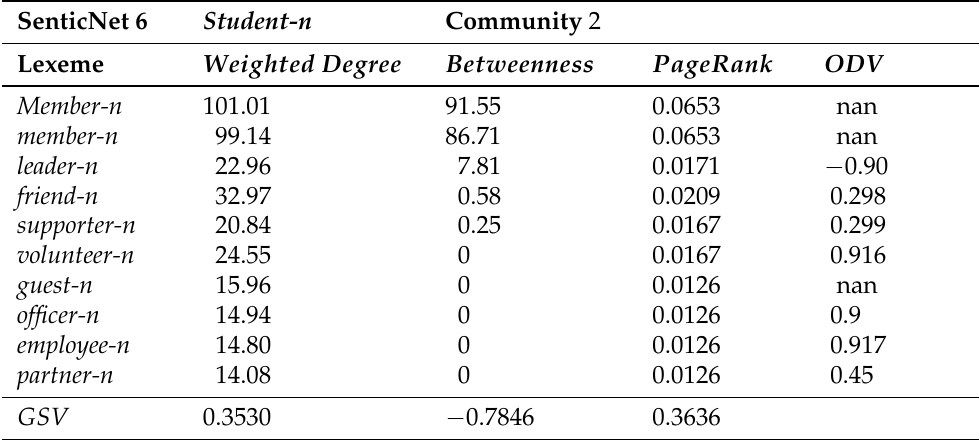
Table 4. GSV of community 2 of lexical dependency graph of lexeme student-n calculated with SenticNet 6 polarity_value on ententen13 corpus.